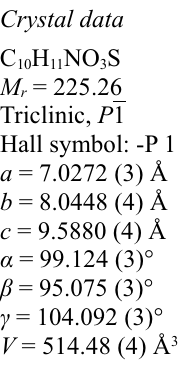
The unit cell packing of (I) (Spek, 2003) showing the intermolecular hydrogen bonds resulting in dimers. 1-Ethyl-1 H -2,1-benzothiazin-4(3 H )-one